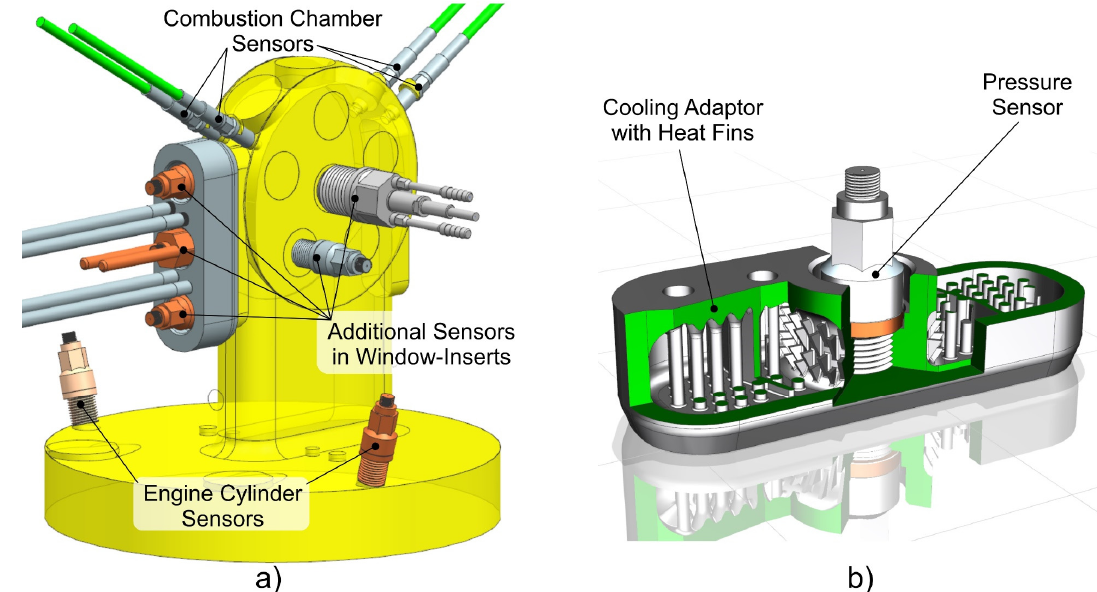
Figure 9. ( a ) The inside (gas) volume of the engine cylinder (piston 20 mm before TDC) and the combustion chamber with pressure sensors mounted in all standard locations plus two inserts. ( b ) Window insert for a single, thermally especially well stabilized pressure